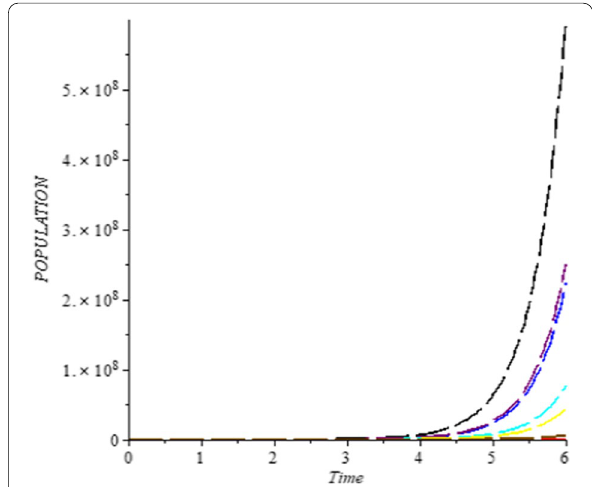
Fig. 12 Effect of k (Rate at which individual leave the exposed class on S , V , E , I , P , A , H , R , F